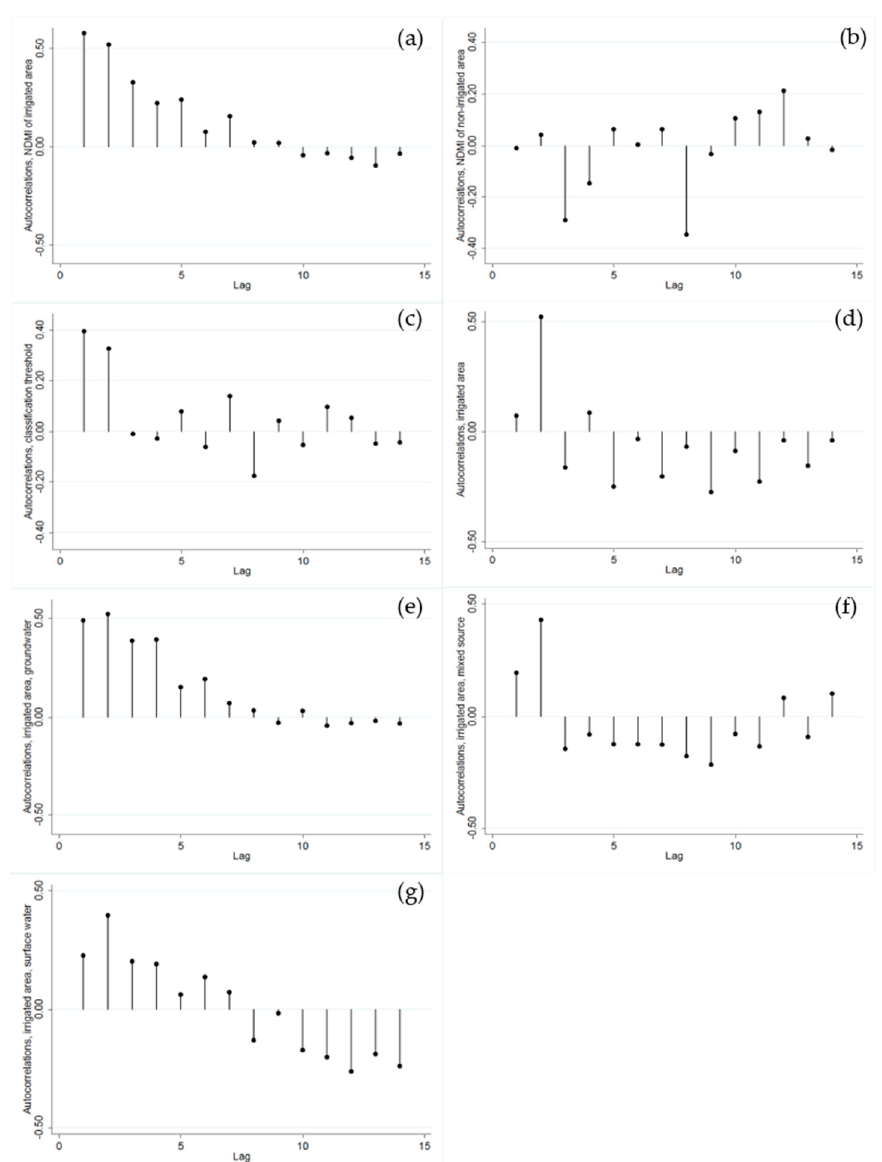
Figure A1. Time series autocorrelation coefficients up to 14 lags for: ( a ) Normalized Difference Moisture Index (NDMI) of irrigated areas; ( b ) NDMI of non-irrigated areas; ( c ) classification threshold; ( d ) irrigated area; ( e ) irrigated area, groundwater only; ( f ) irrigated area, mixed source; and ( g ) irrigated area, surface water only. ( a – d ) are for time series from Figure 2; ( e – g ) are for time series from Figure 5.